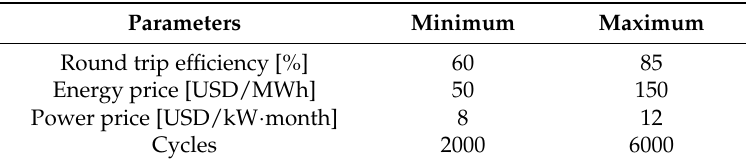
Table 5. Sensitivity